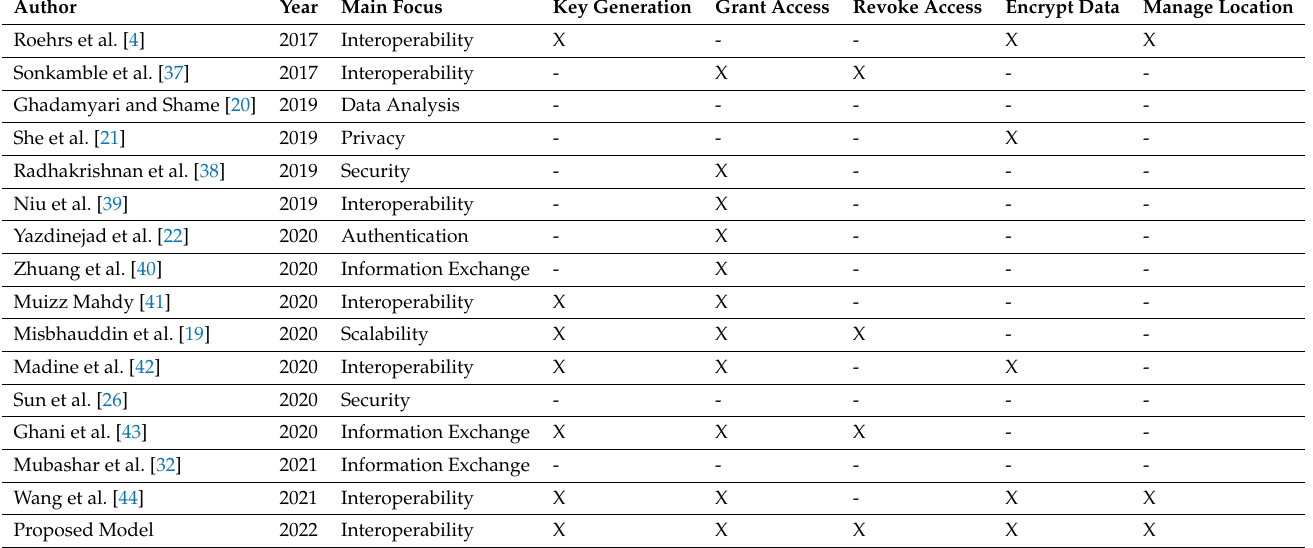
Table 2. Related work: Comparison analysis of previous studies in terms of opportunity for individu- als to create cryptographic keys, digitally agree or deny access to PHR, use their own keys to encrypt data, and choose the infrastructure to store PHR. Comparison of previous studies in terms of their focus on EHR and